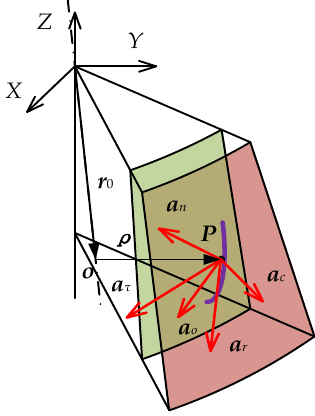
Figure 6. The acceleration components of spatial sliding particle.